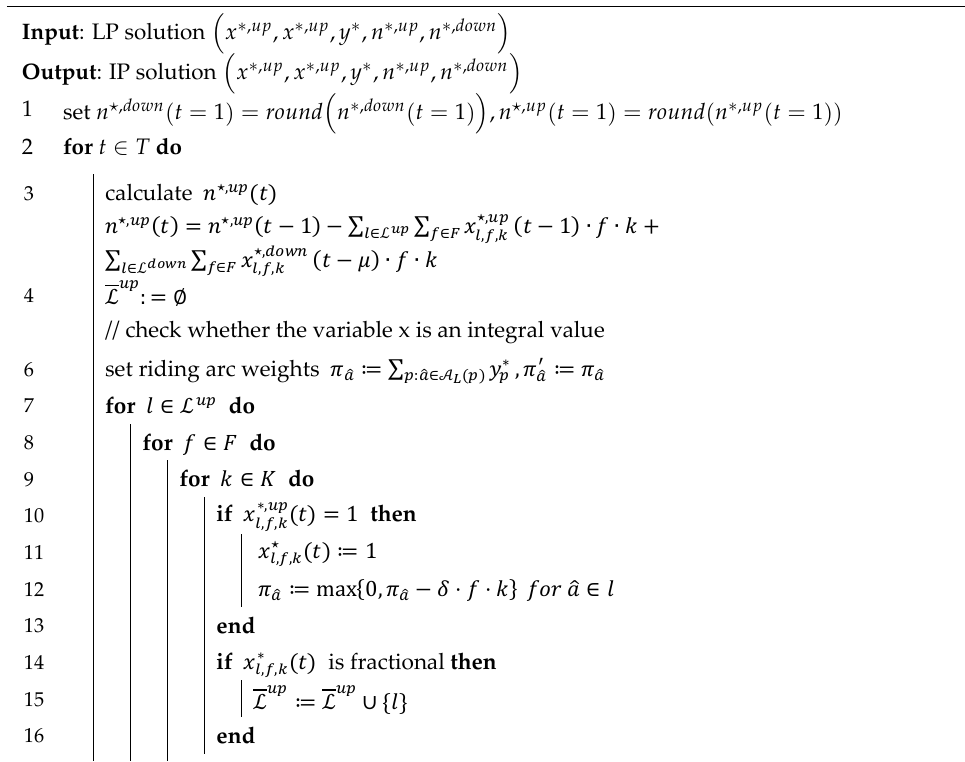
Algorithm 1: The improved round heuristic algorithm.